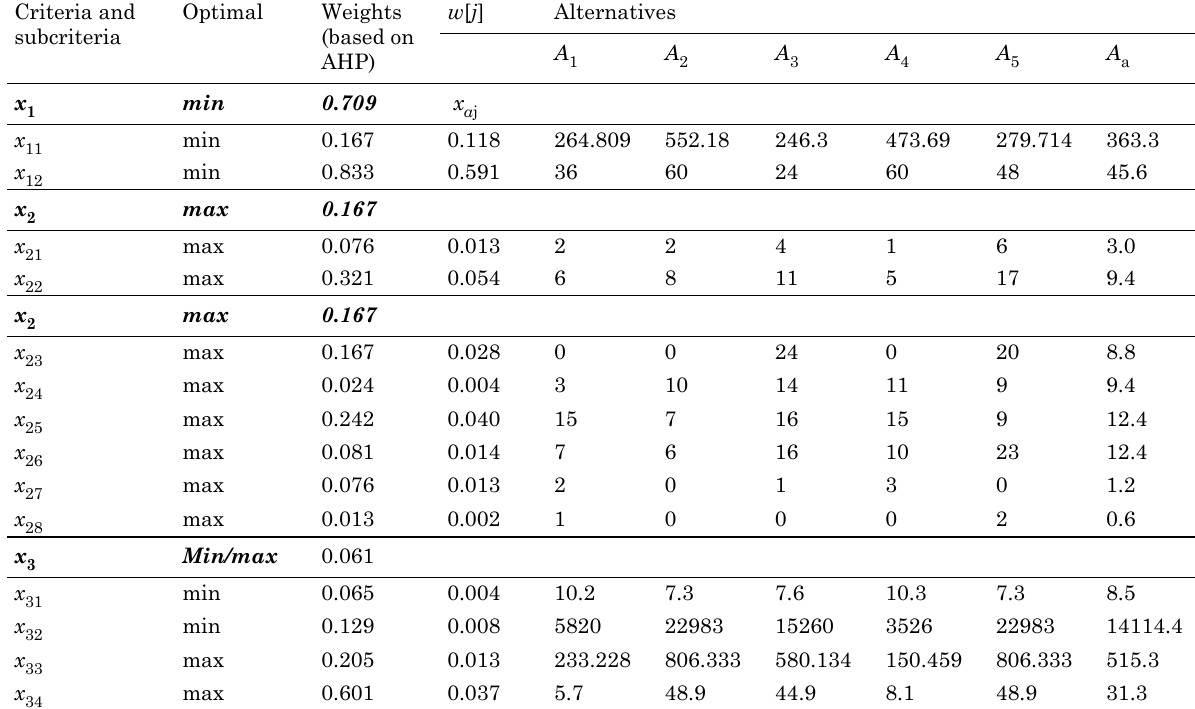
Table 3. Initial data Criteria and subcriteria